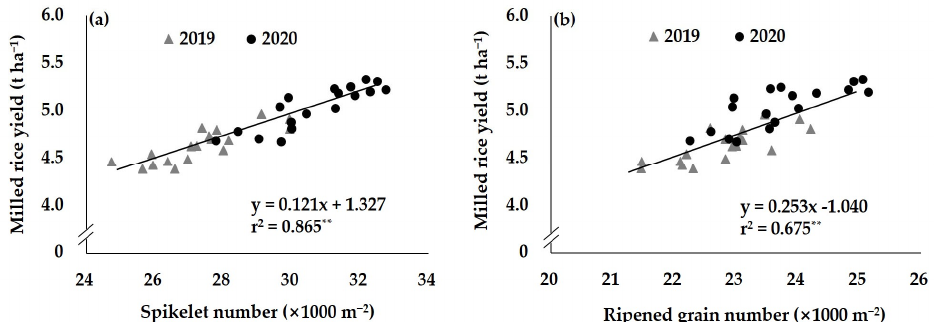
Figure 4. Relationship between the milled rice yield and ( a ) spikelet number m − 2 and ( b ) ripened grain number m − 2 . **: significant at p < 0.01.